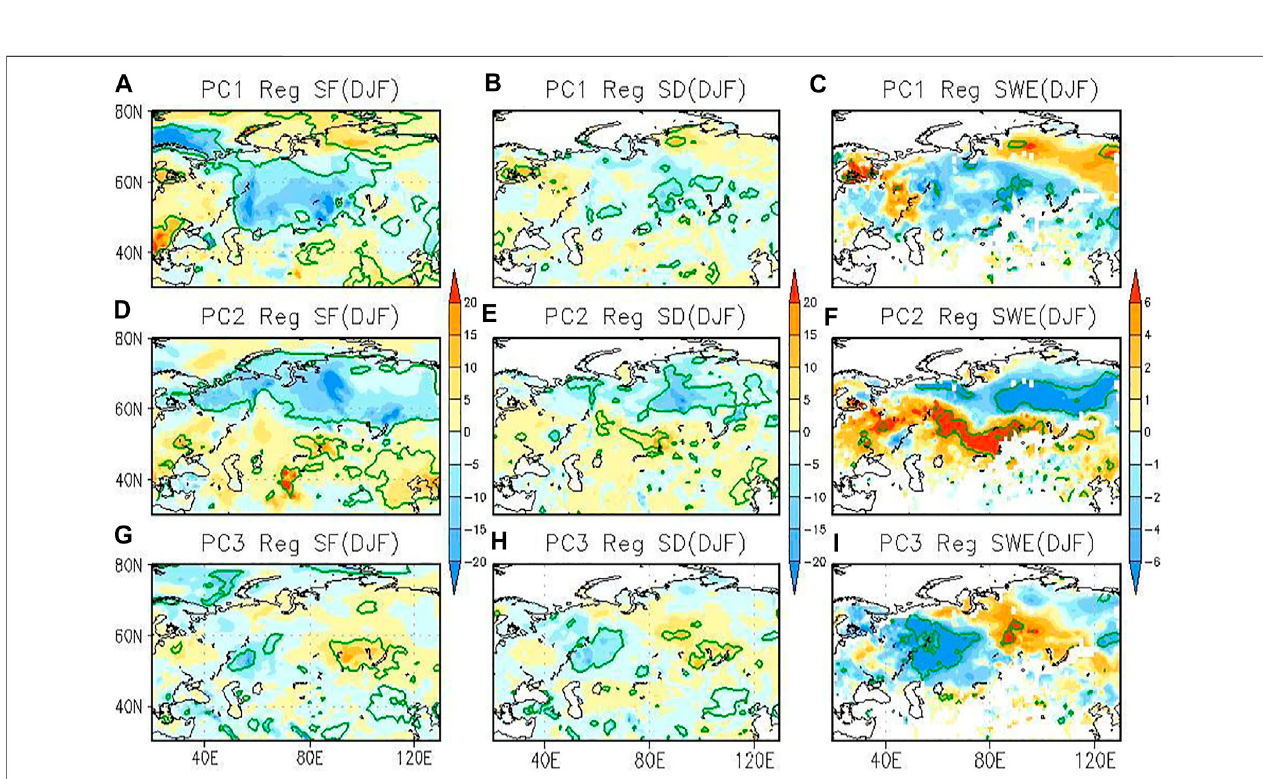
FIGURE 5 | Regressed anomalies of DJF (A) snow fall (shading, units: mm), (B) snow depth (shading, units: mm), and (C) snow water equivalent (shading, units: mm) onto PC1, (D – F) onto PC2, and (G – I) onto PC3. The green line indicates the value signi fi cantly exceeding the 95% con fi dence level.